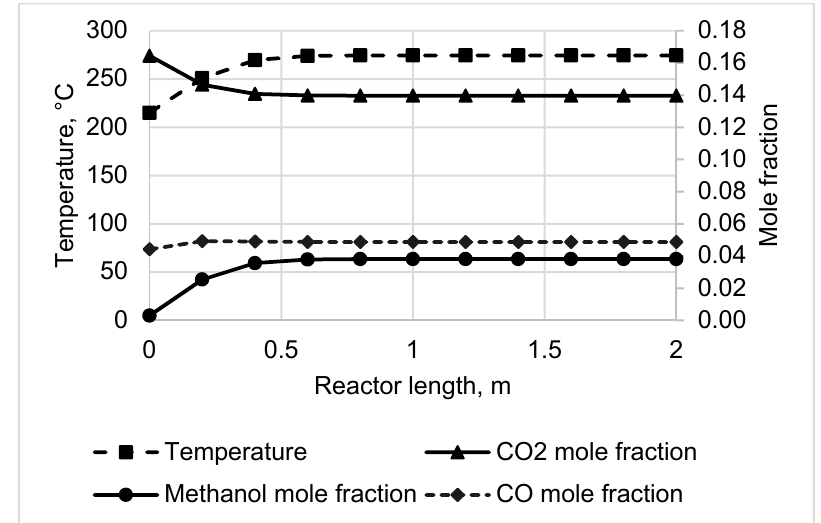
Figure 4. Reactor temperature and composition profile in the gas-phase CO 2 hydrogenation to methanol process. Adiabatic reactor, inlet temperature 215.0 °C, and pressure 52.0 bar.